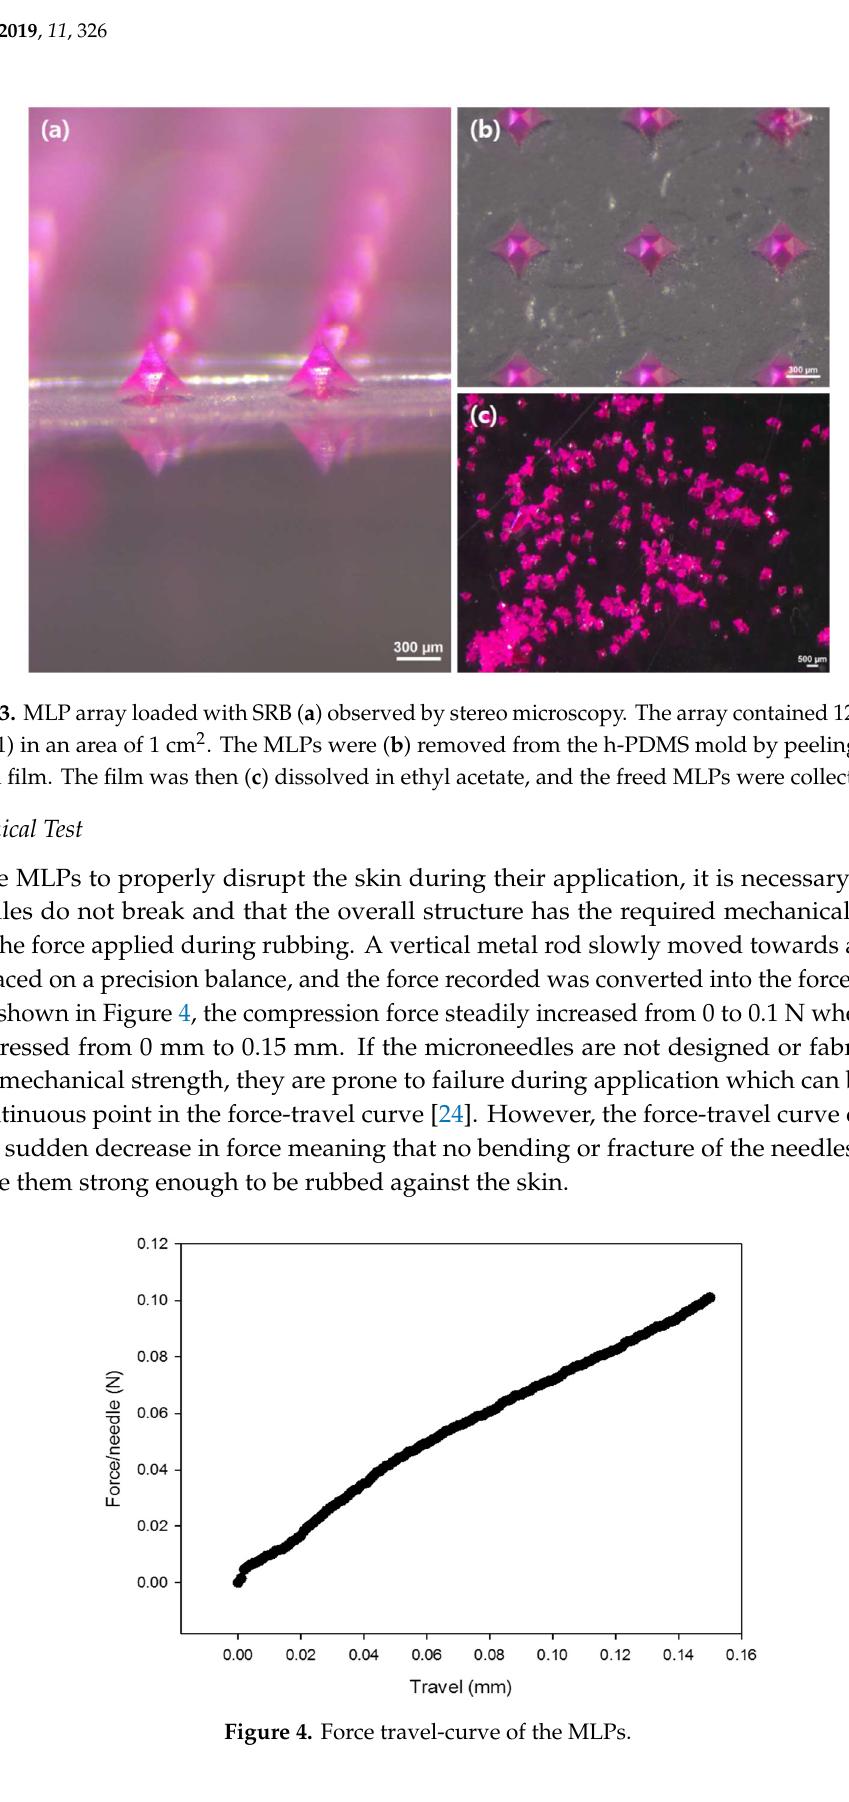
Figure 4. Force travel-curve of the MLPs.